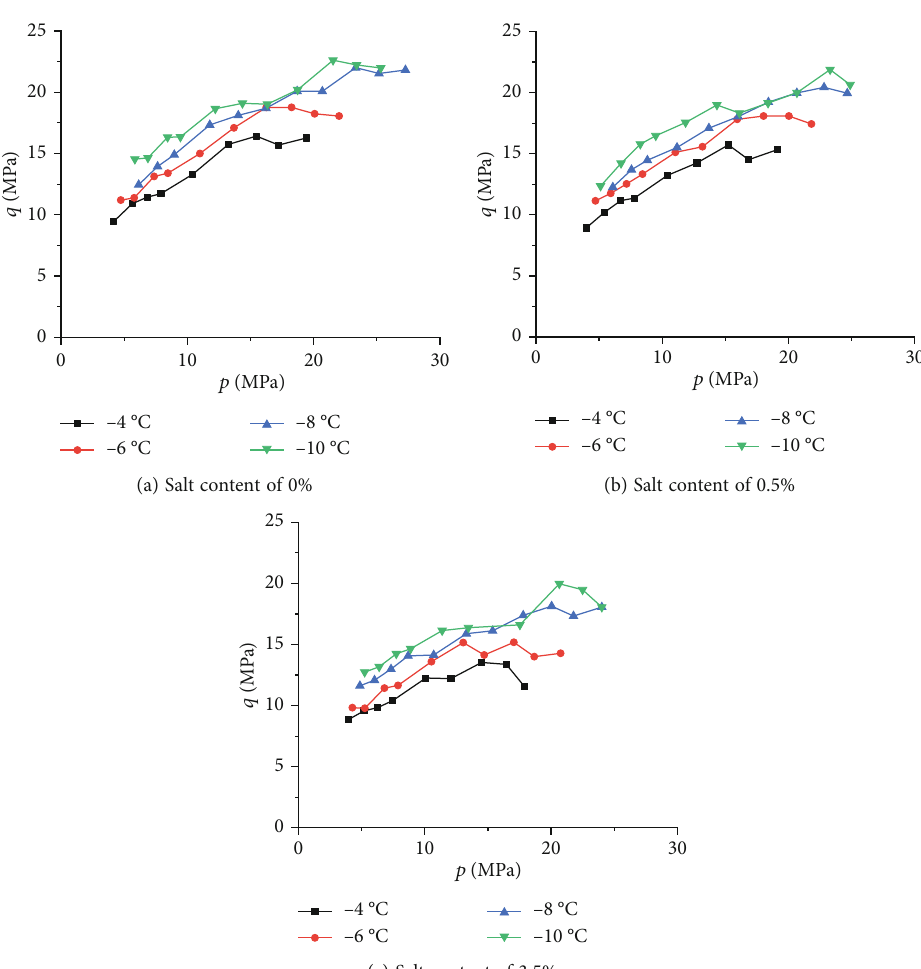
Figure 2: Failure strength results for frozen saline sandy samples at di ff erent temperatures.